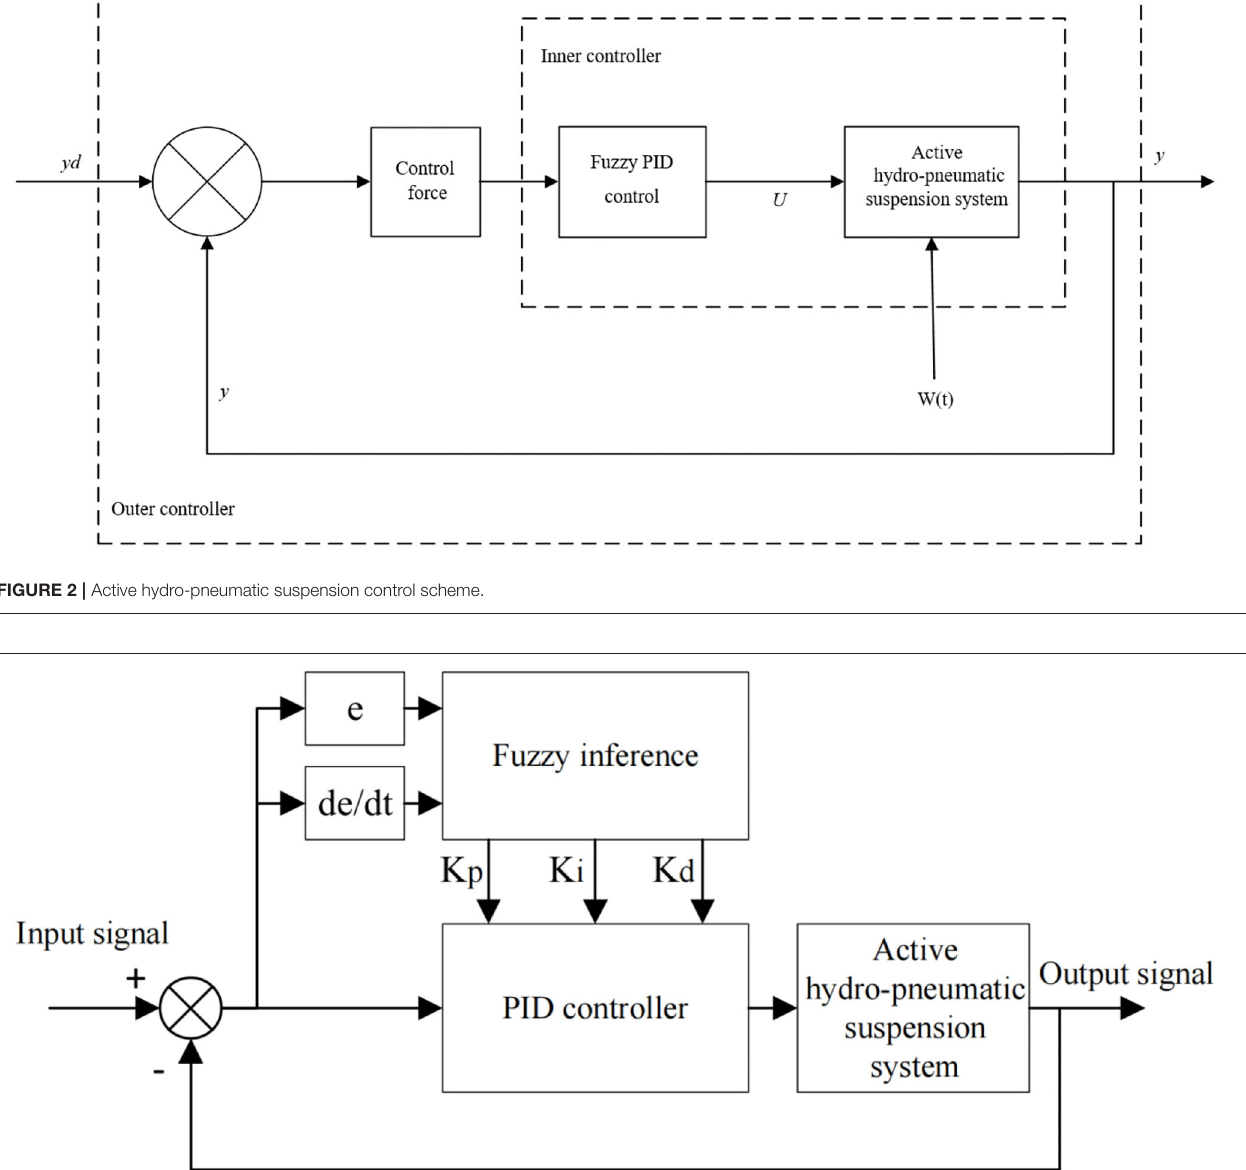
FIGURE 3 | Fuzzy PID control flow